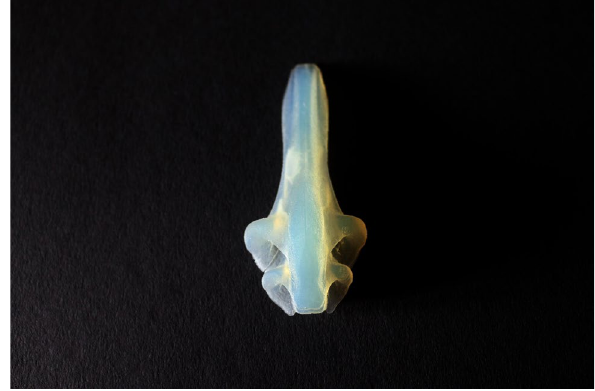
Figure 4 | Nose project Double nostrils – photo of 3d printed object in Flexible material Tango Plus 9740 . Technology polyjet solidified liquid photopolymer by using UV